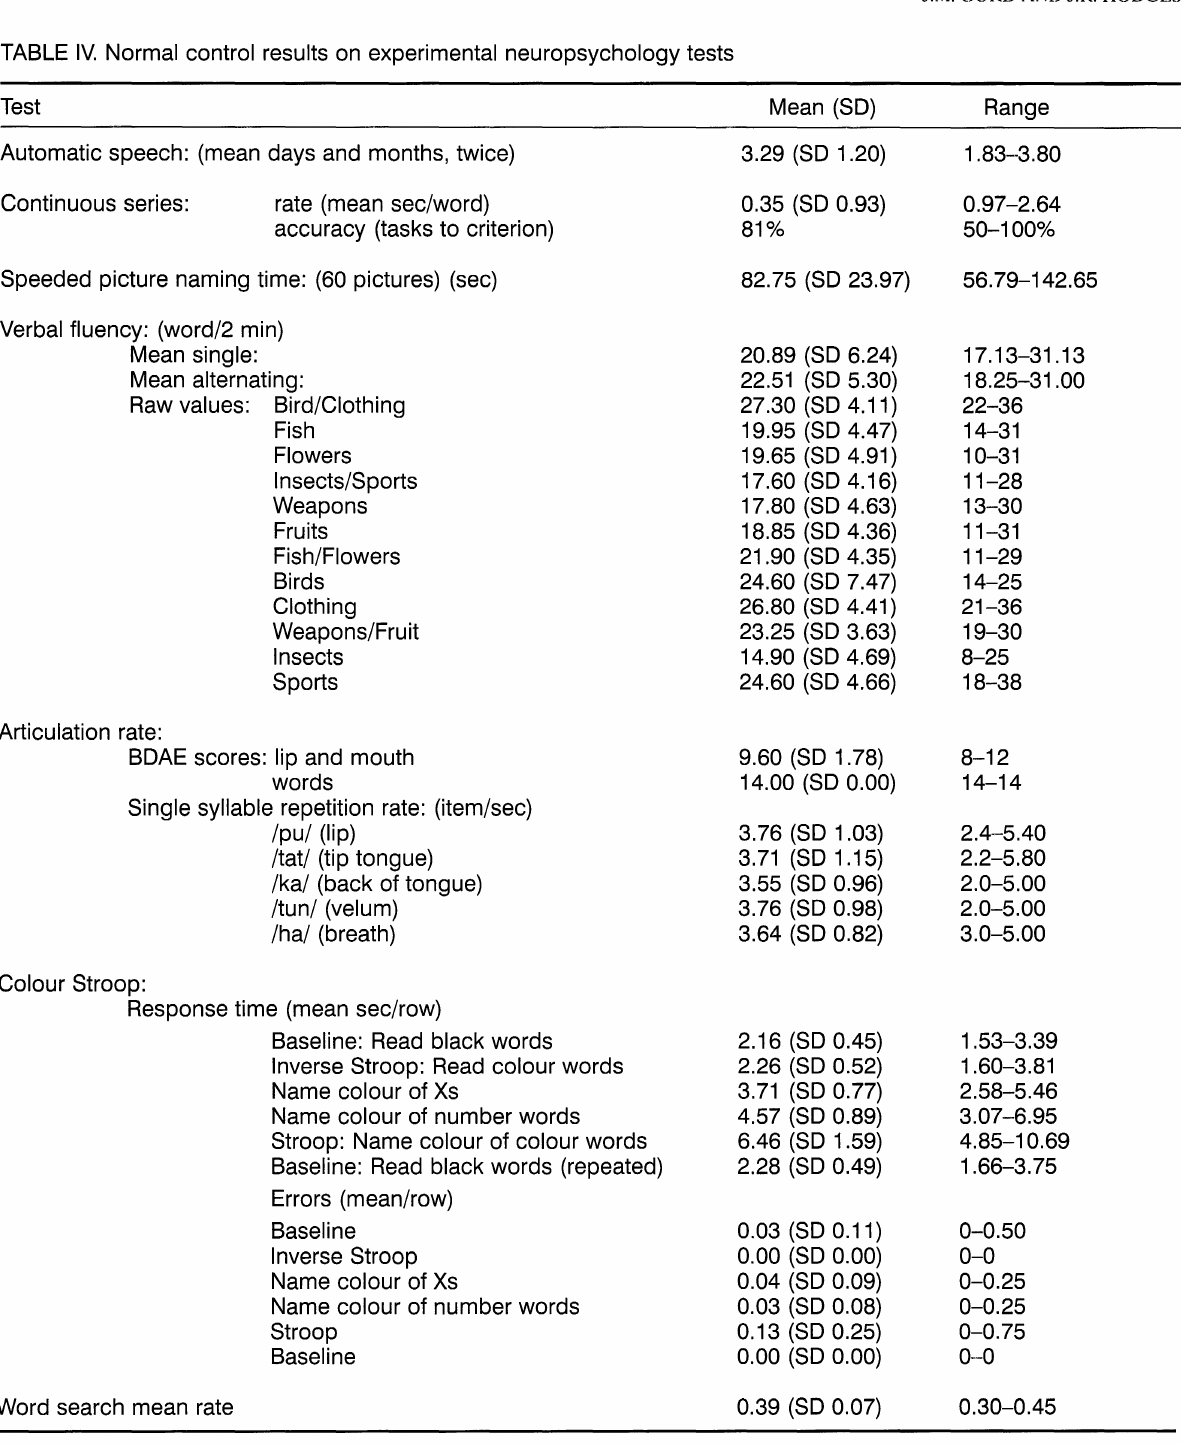
TABLE IV. Normal control results on experimental neuropsychology tests